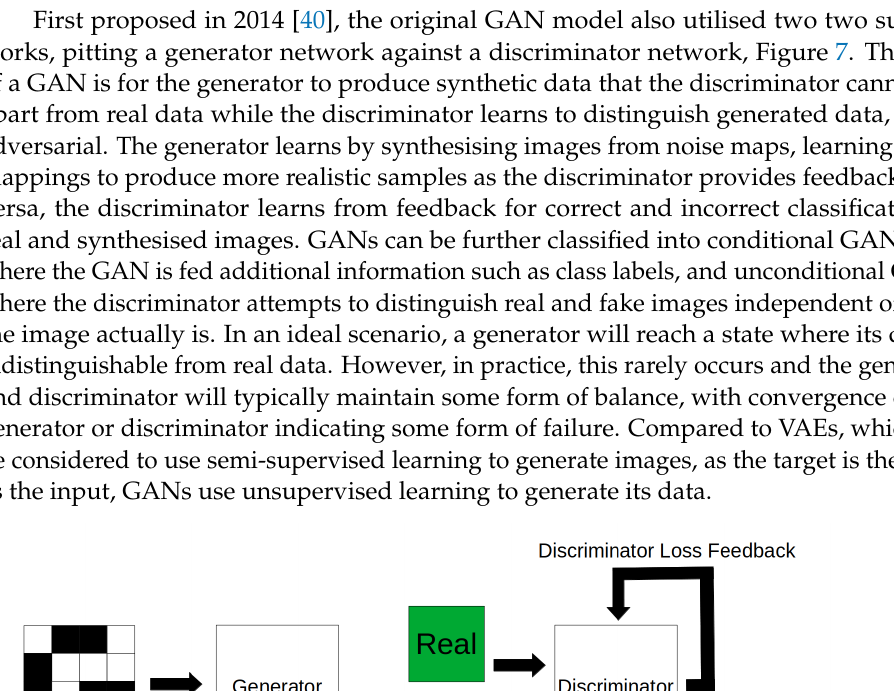
Figure 6. Variational Autoencoder training process.